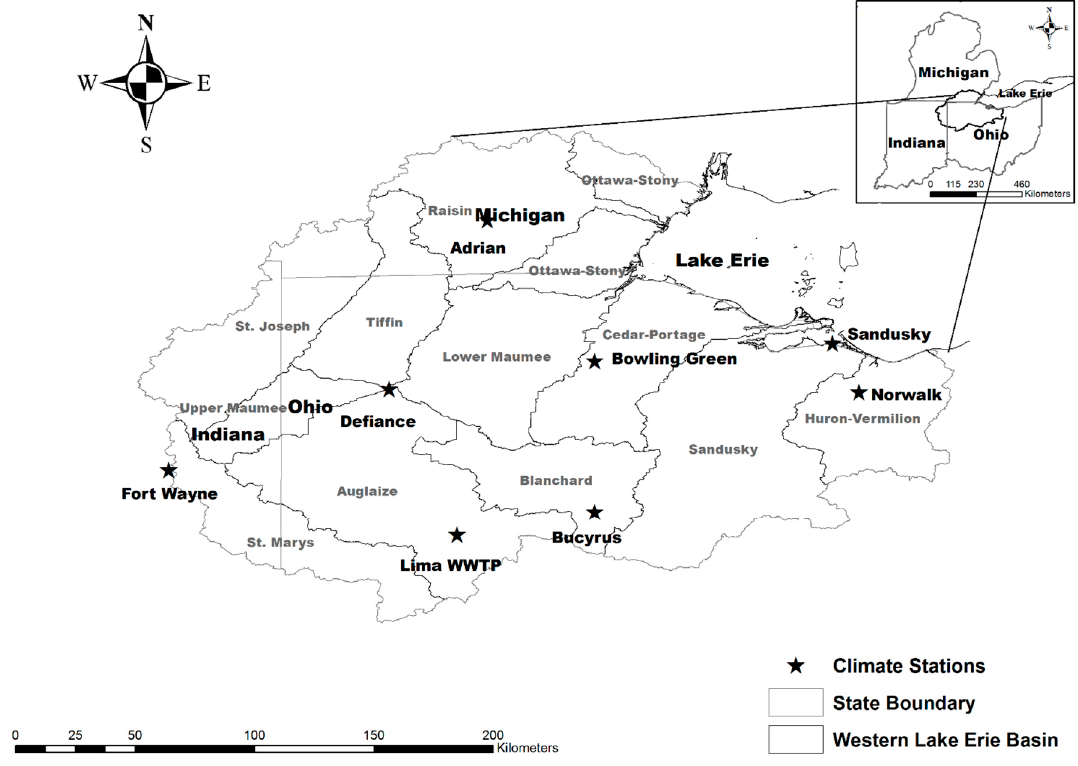
Figure 1. Pilot site: The Western Lake Erie Basin (WLEB) and different ground-based climate stations considered in this study.